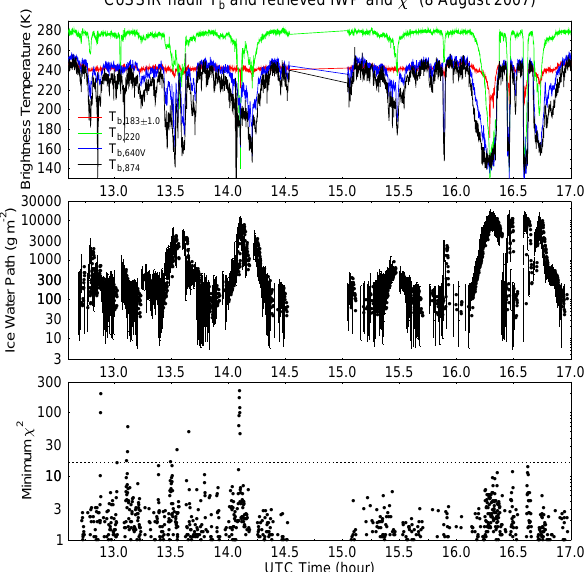
Fig. 11. CoSSIR brightness temperatures from 17 July for four channels (top panel). Retrieved ice water path with error bars of cloudy pixels (middle panel). Minimum χ 2 (bottom panel); the dot- ted line at χ 2 of 21.7 is the 99% significance level for 9 channels.